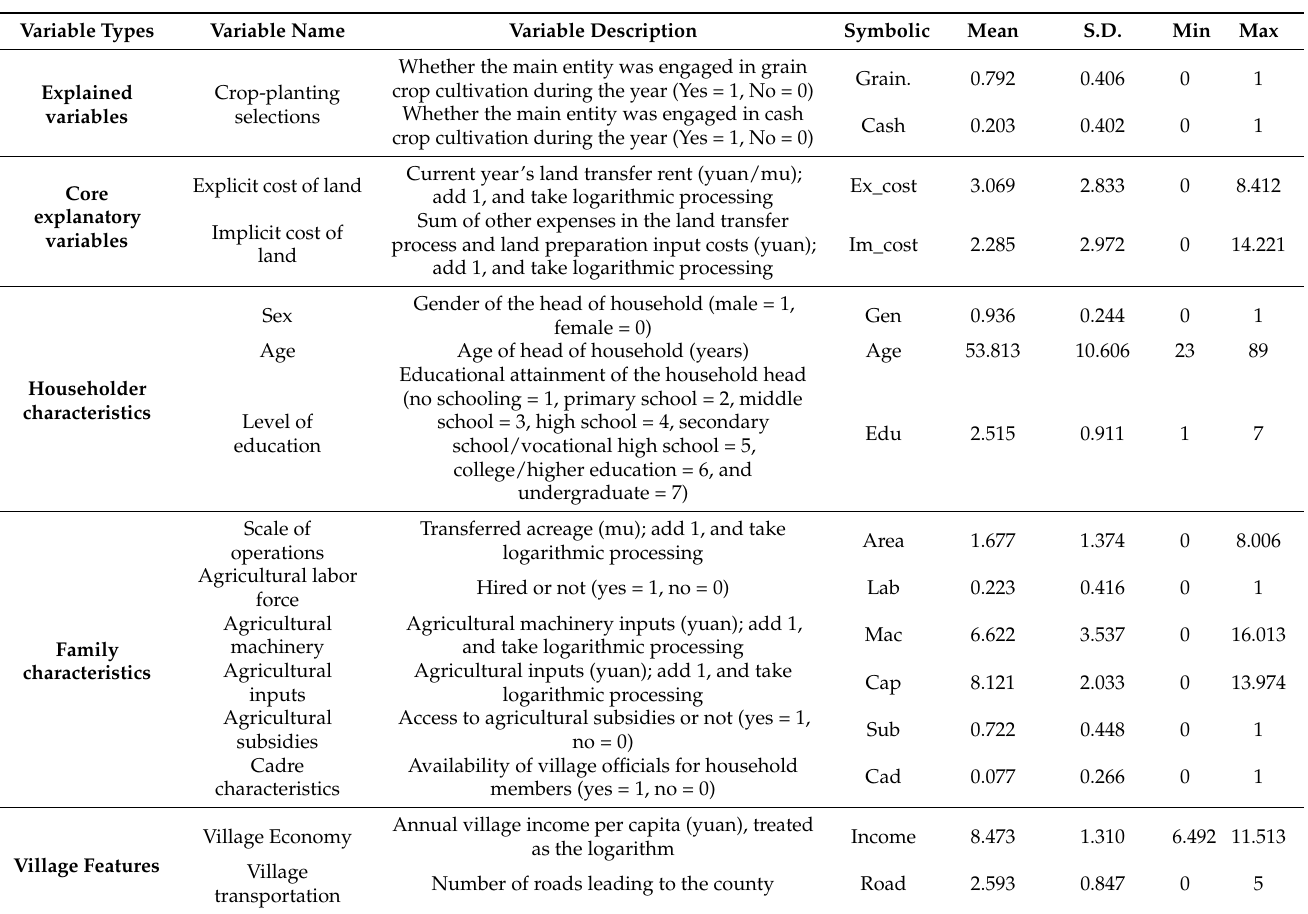
Table 1 lists the descriptive statistics of the variables (Table 2). Table 2. Descriptive statistics of